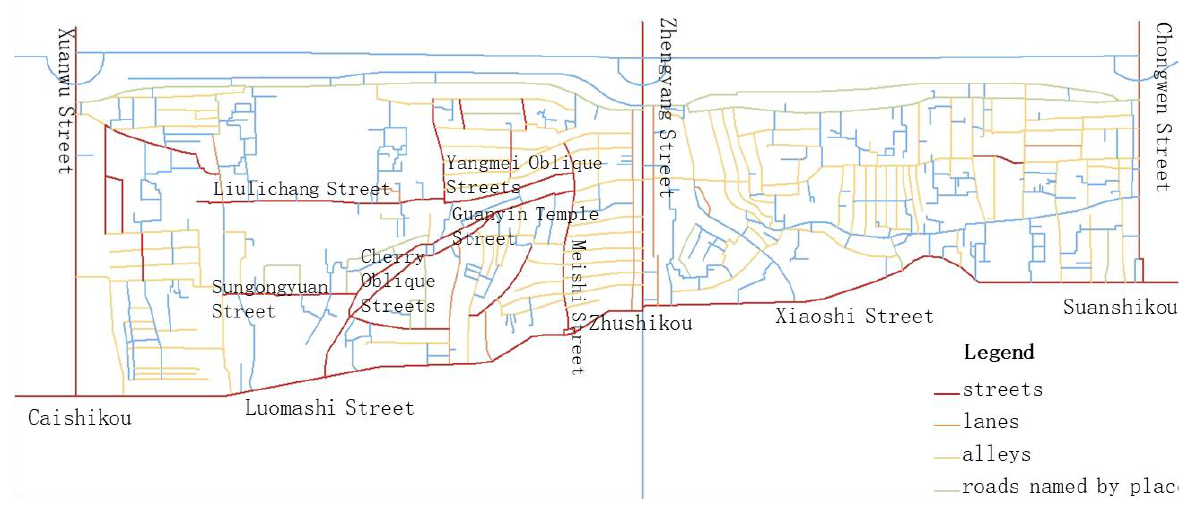
Figure 6. Name classification of streets and alleys in Qianmen area during the Qianlong dynasty